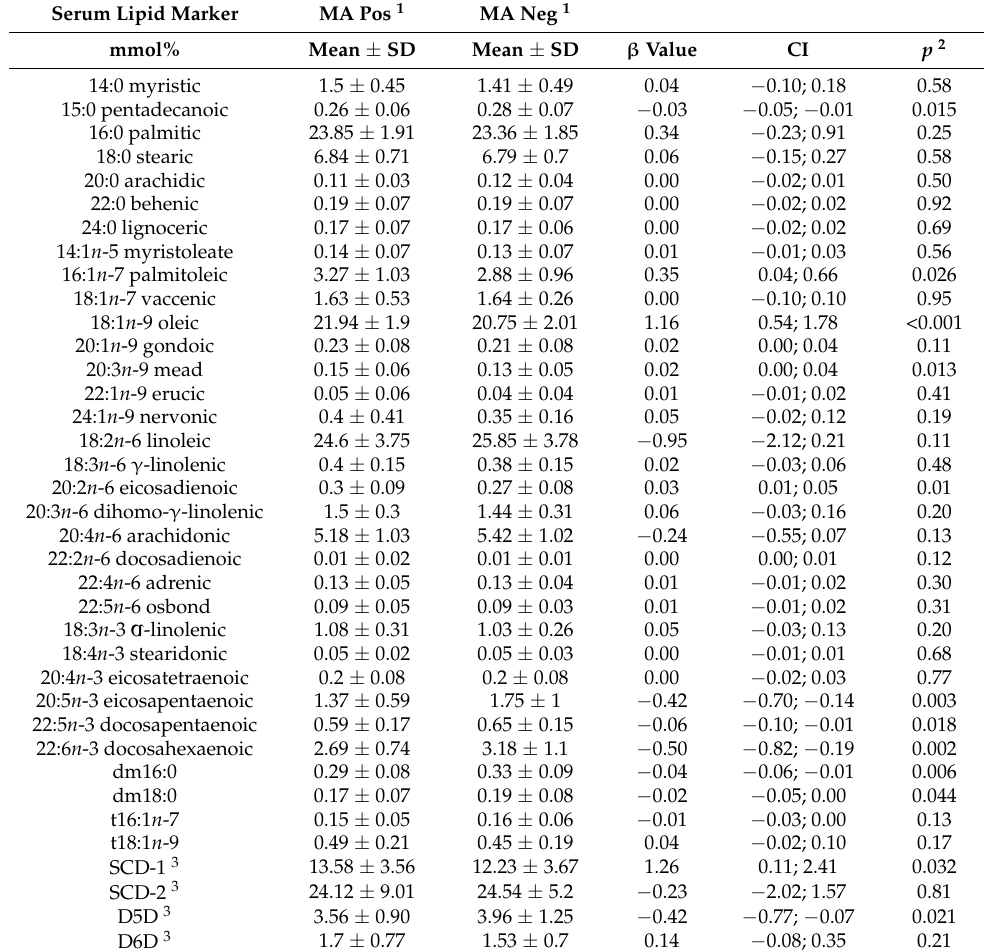
Table 2. Serum fatty acids, plasmalogens metabolites and estimated desaturases according to the occurrence of retinal microangiopathy (MA), and associations of MA with the serum fatty acids, plasmalogens metabolites and estimated